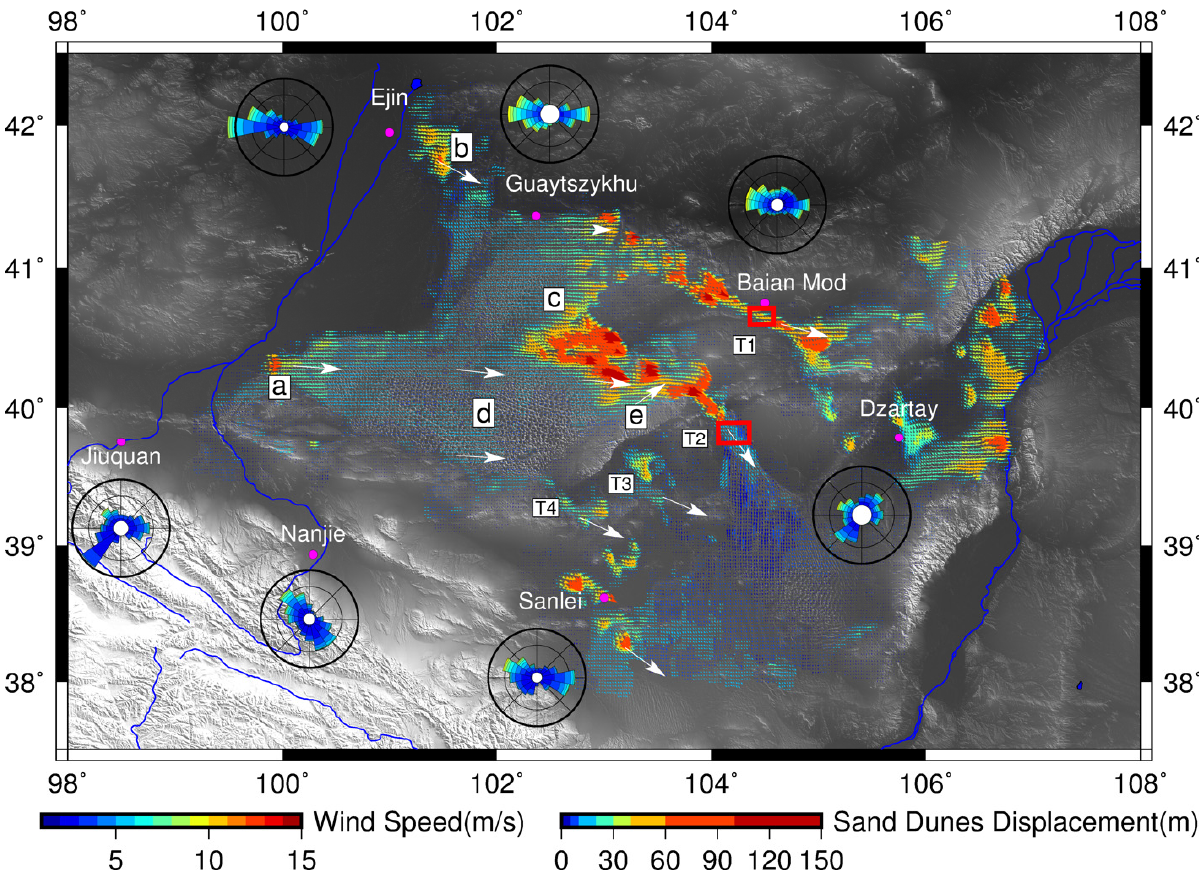
Figure 6. Displacement map of dunes in the BJD and the surrounding area. The white arrows show the directions of the local dune displacements. The wind roses show the wind direction and speed over the last 10 years: ( a – e ) show the locations of the different displacement areas, and ( T1 – T4 ) show the locations of sand transporting pathways from the BJD to the TD and UBD. The red rectangles show the area used for sand flux estimation.